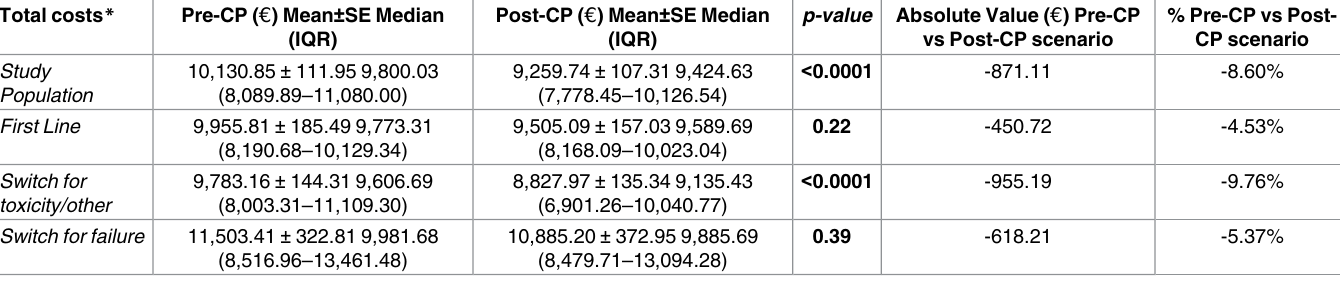
Table 7. Mean yearly per-patient total costs, Lombardy Region, Italy, comparing Pre-CP (2009–2010) and Post-CP (2011–2012), evaluated with 2014 price and reimbursement tariffs. Total costs * Pre-CP ( € ) Mean ± SE Median